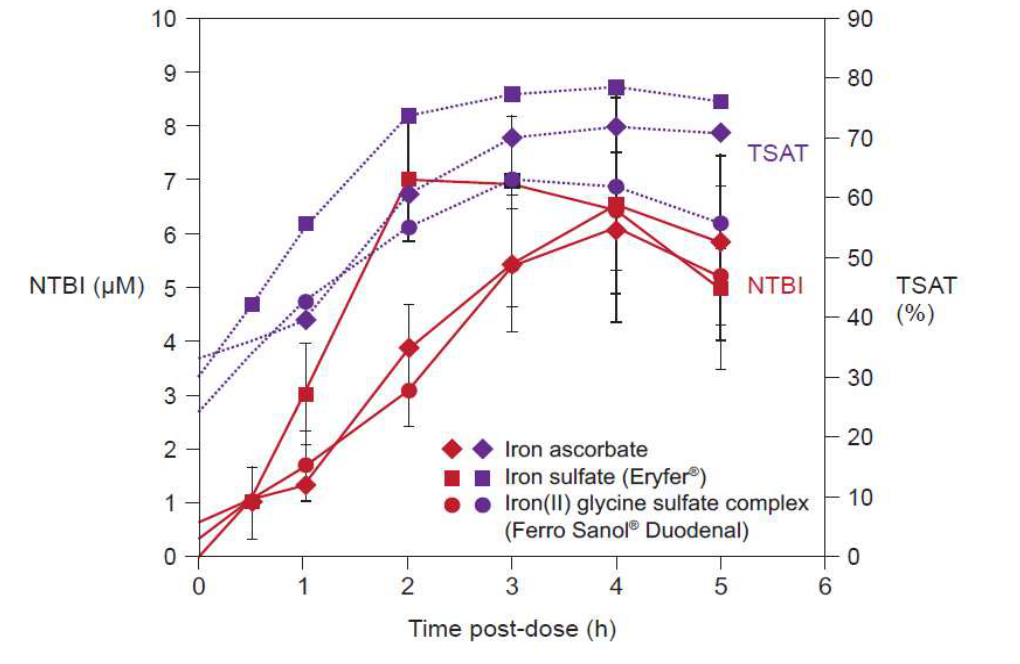
Figure 4. Serum concentration of non-transferrin bound iron (NTBI) and percentage transferrin saturation (TSAT) following administration of a single oral dose of 100 mg iron in the form of three different ferrous salts to healthy adult volunteers. Broken blue lines indicate the percentage transferrin saturation (right-hand axis). Solid red lines indicate NTBI concentration (left-hand axis). Values shown are mean ± SD. Modified from Dresow et al . 2008 [34].